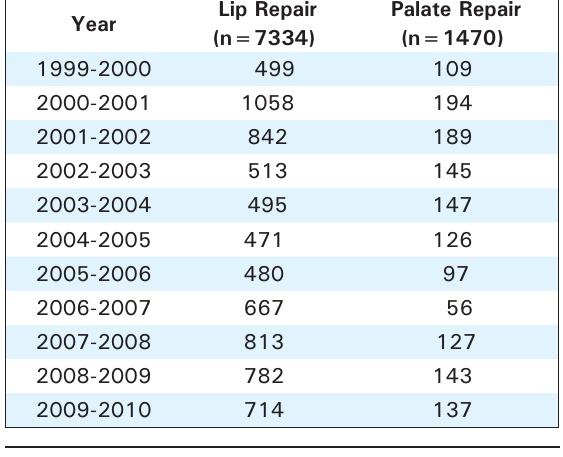
Table 2. Yearly distribution of mean and median age at the time of the cleft lip and cleft palate repair (